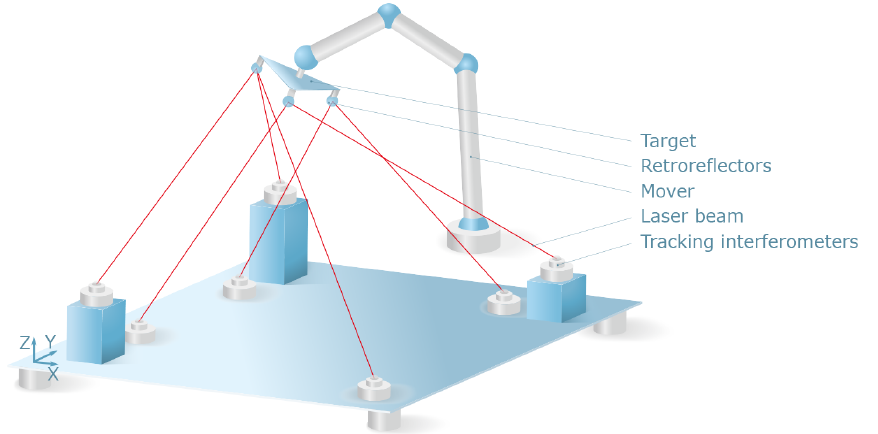
Figure 1. Measurement principle of 6-DoF multilateration. A set of tracking laser interferometers is placed in a non-coplanar arrangement and measures a multitude of distances to a target assembly of three